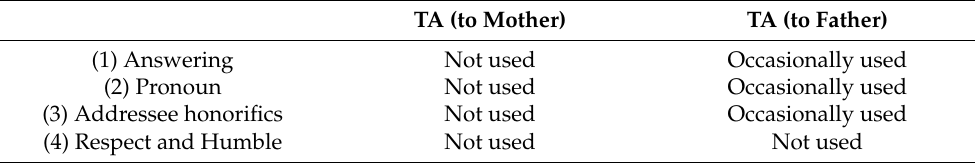
Table 5. Whether the new speaker uses traditional honorifics for her